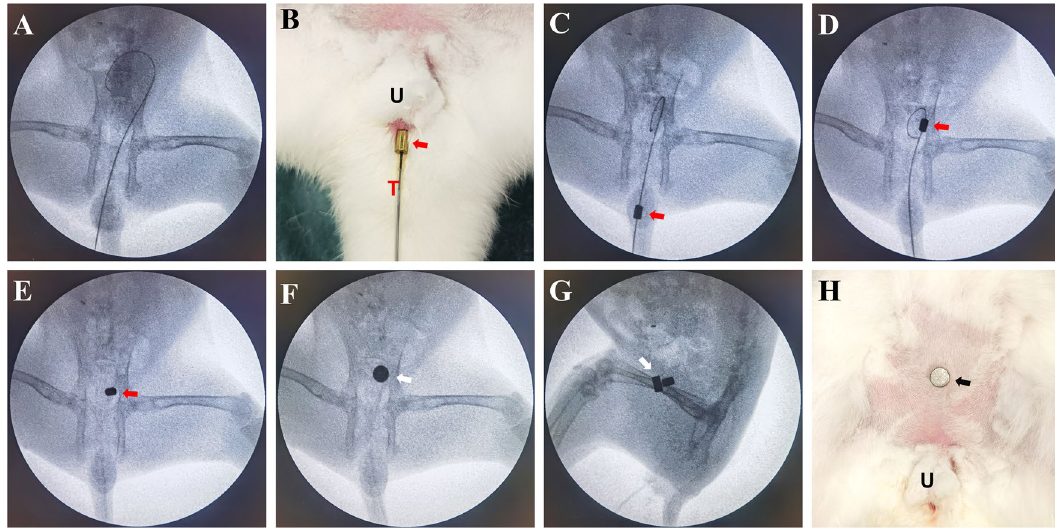
Figure 3. Representative intraoperative images. ( A ) X-ray image obtained after the guide wire had entered the bladder. ( B ) Daughter magnet (red arrow) is being inserted through the urethra (U) with the help of a scalp needle tube (T). ( C – E ) The daughter magnet is inserted into the bladder along the guide wire. ( F ) Anteroposterior radiograph showing the two magnets attracted together (white arrow). ( G ) Lateral radiograph showing the two magnets attracted together. ( H ) Photograph showing the parent magnet (black arrow) on the abdominal wall.